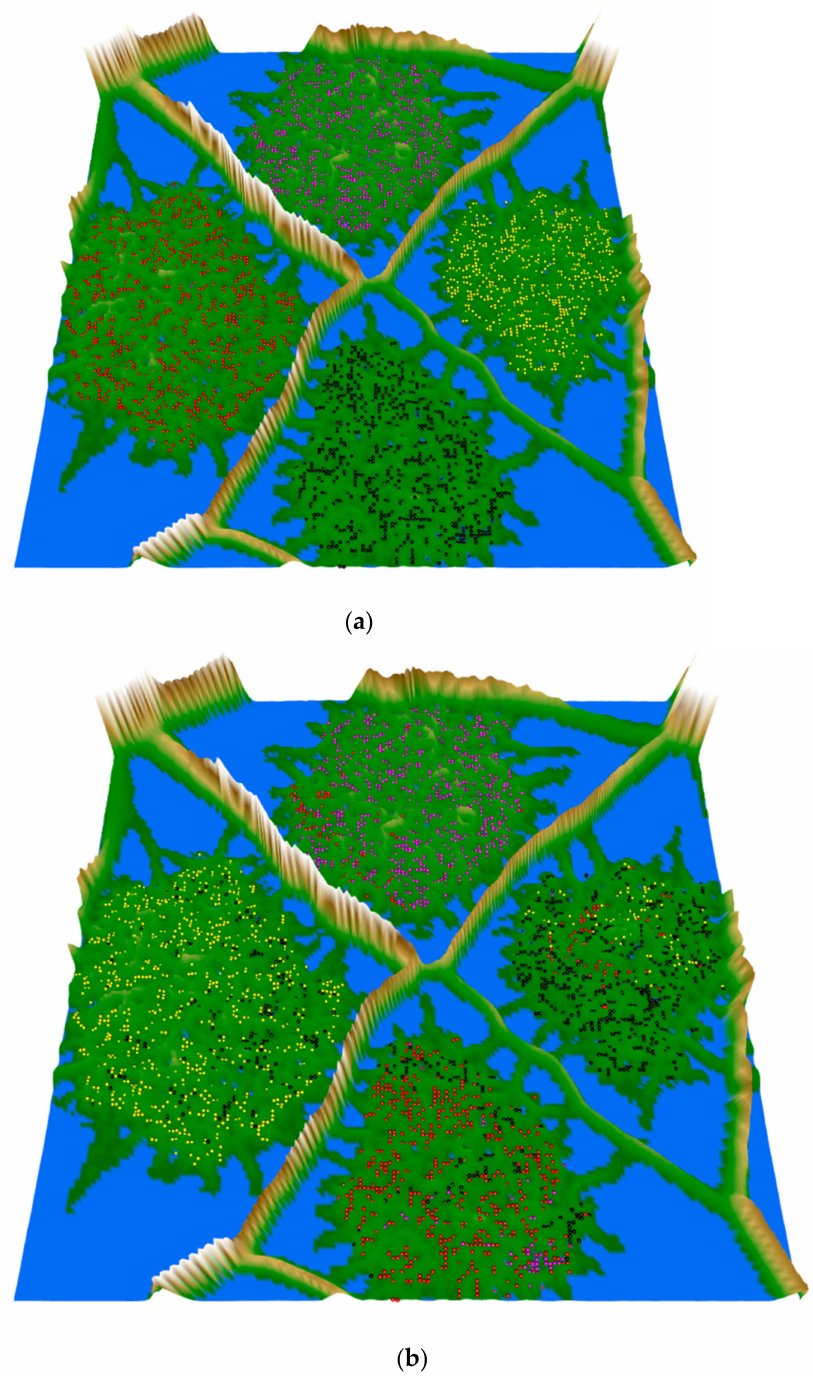
Figure 10. Topographic maps with hypsometric tints using t stochastic neighbor embedding (t-SNE) and the generalized U-matrix. The topology of the map is toroidal (the top and bottom and as well the right and left are joined). Each colored sphere represents a rainstorm with its different classification, as it has already computed. ( a ) Results using FCM: the rainstorms that belong to the same cluster are separated by mountain ranges. ( b ) Results using Huff’s classification: the rainstorms of different classification are mixed, despite the visual separation of mountain ridges in the